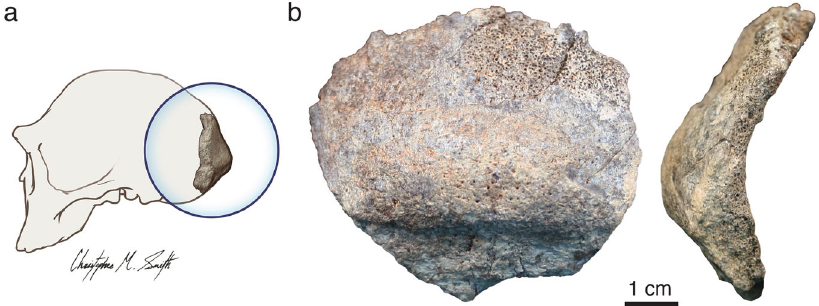
Fig. 1 KNM-ER 2598 partial occipital. a Inset image indicates the approximate anatomical location of the KNM-ER 2598 occipital. b Posterior view and right lateral view are